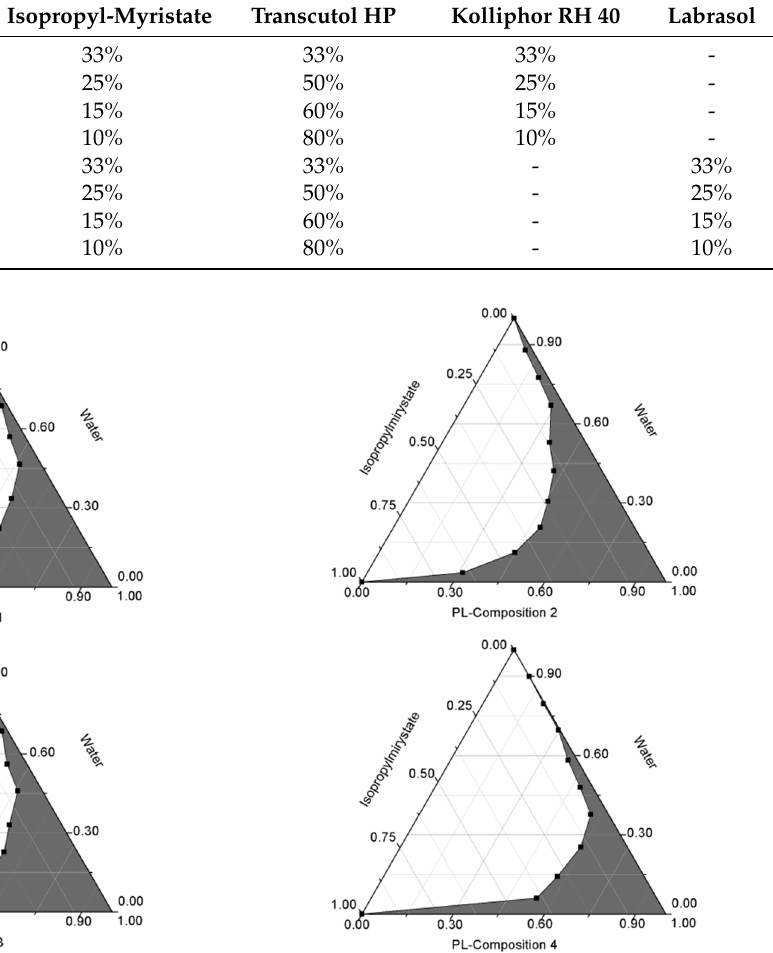
Table 2. Compositions of Plantago lanceolata extract (PL-SNEDDS) ( 1 – 8) . The components were Isopropyl myristate as oily phase, Labrasol or Kolliphor RH 40 as surfactant, and Transcutol HP as co-tenside. The concentration of Plantago lanceolata extract was 10 mg/mL in all